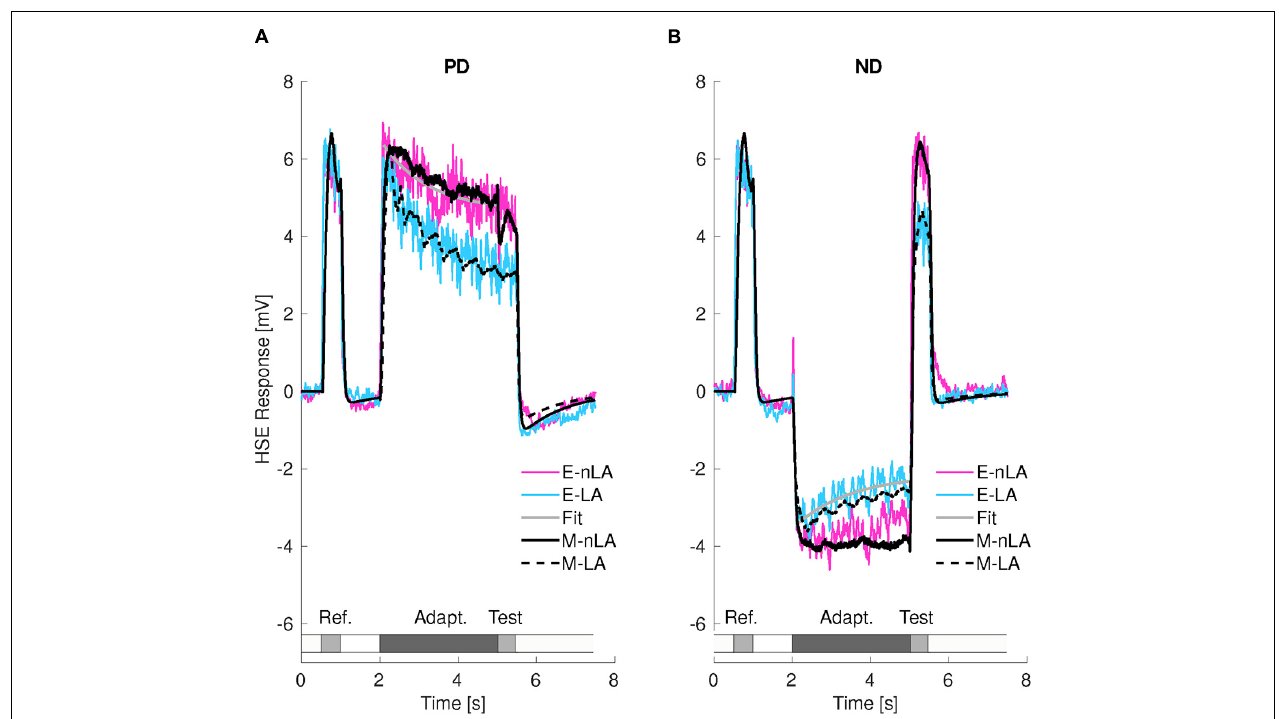
FIGURE 3 | Consequences of motion adaptation for the HSE-cell and the adaptive model of the visual motion pathway. (A) Average time-dependent responses of 13 HSE-cells for preferred direction (PD) motion with local motion adaptation (LA, cyan trace) and without local motion adaptation (nLA, magenta trace). Smooth gray line is the fitted curve used for estimating the time constant of wide-field motion adaptation (see Methods). The black traces represent the corresponding responses of the adaptive model of the visual motion pathway. The stimulation protocol is schematically illustrated below the cell response. (B) Same as in panel (A) , however, for null direction (ND) adaptation. Smooth gray line is the fitted curve used for estimating the time constant of local motion adaptation (see section “Materials and Methods”). The resting potential was subtracted from the responses for the experimental results, which were for- and backward low-pass filtered with a time constant of 180